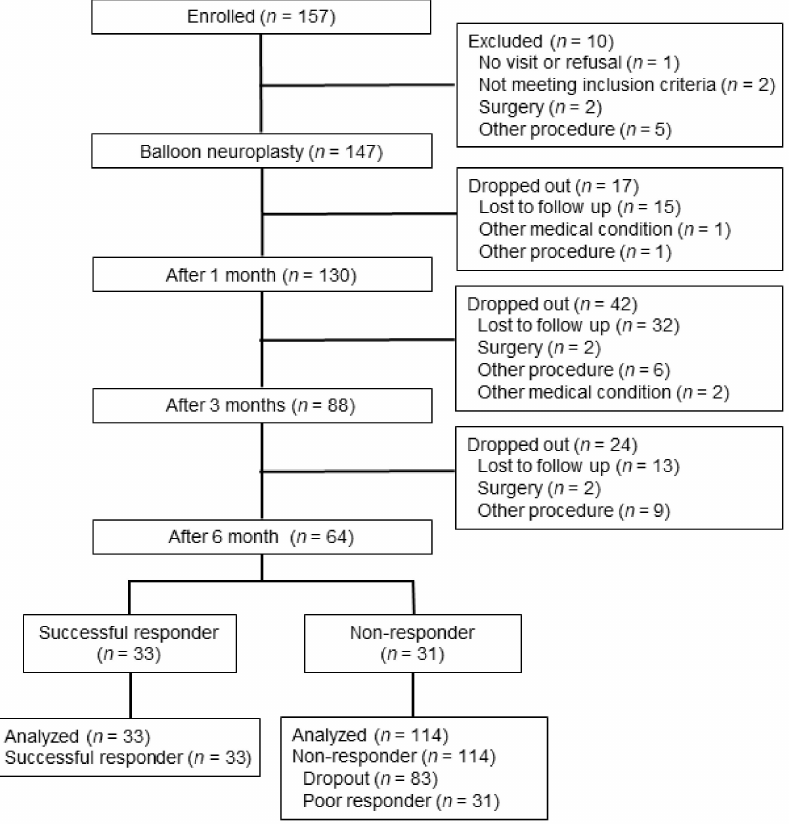
Figure 3. Schematic flow diagram depicting participant